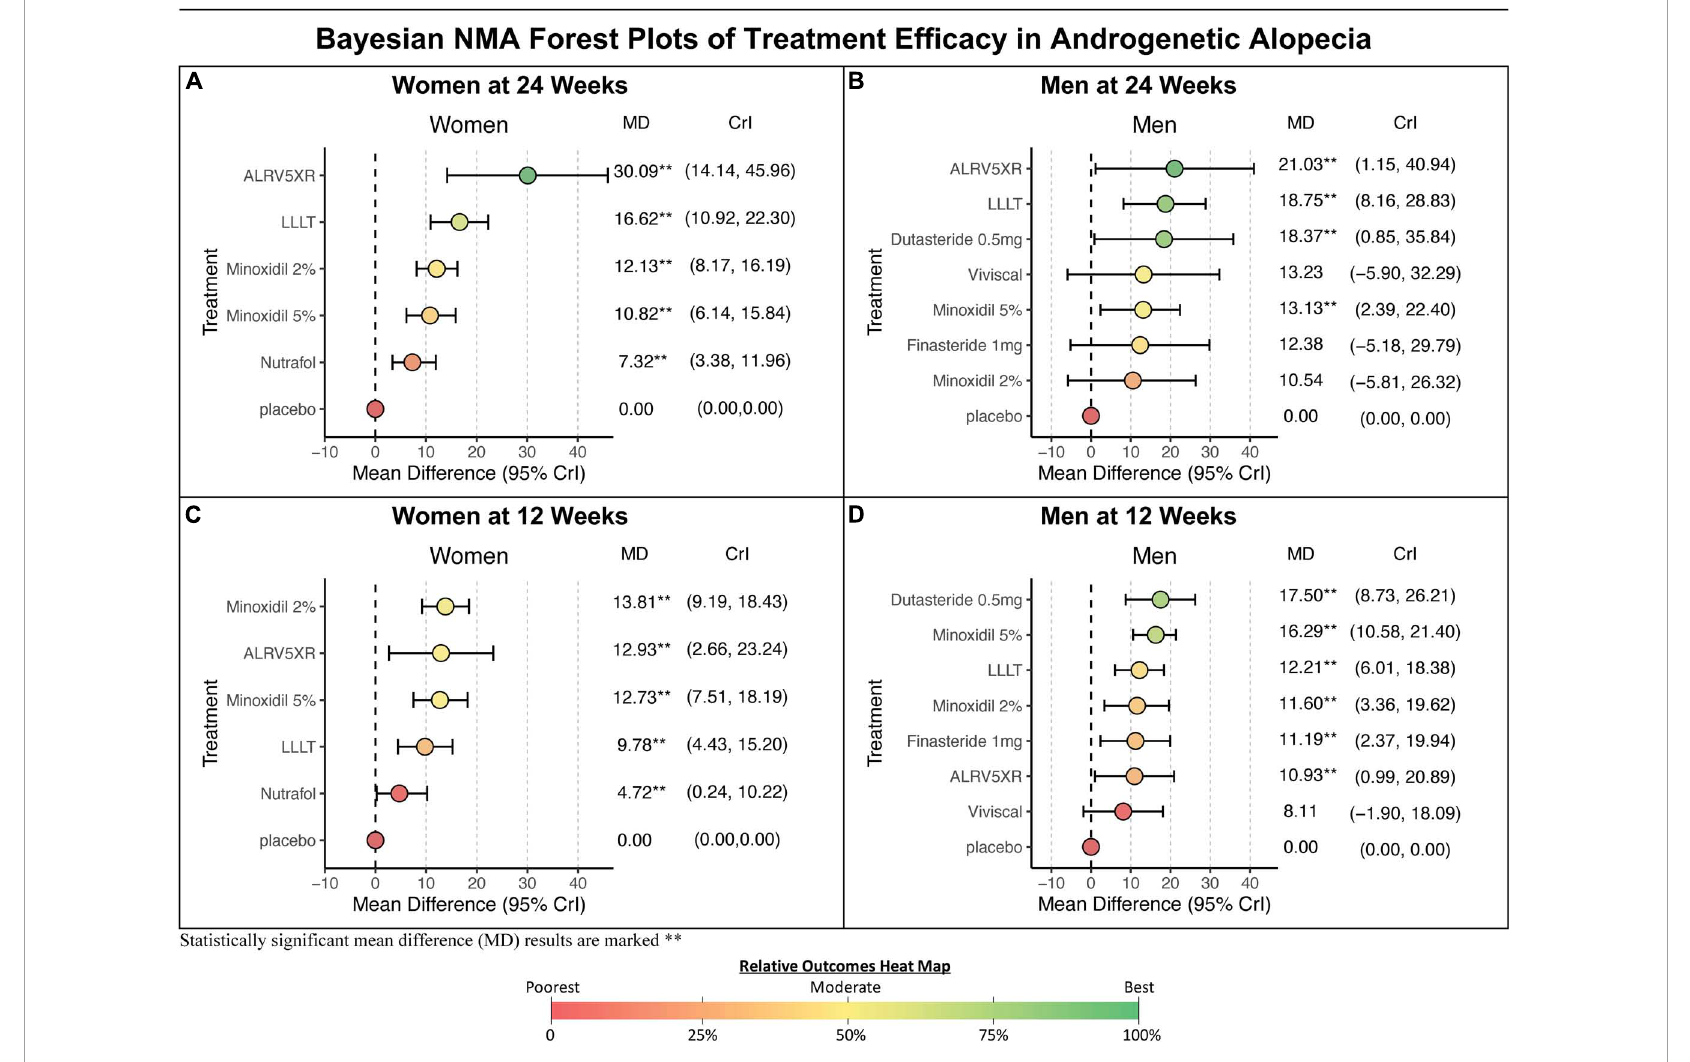
FIGURE5 Bayesian NMA forest plots. Results of Bayesian network meta-analyses (NMA) forest plots show mean differences (MD) between treatment vs. Placebo for changes in terminal hair per cm 2 from baseline. (A,C) Results for women. (B,D) Results for men. Results are ranked in descending order of MD with 95% credible intervals (CrI). Bayesian statistical significance is marked, **. The colors of treatment MD’s correspond with the heat map colors of Bayesian NMA results in Figure 4